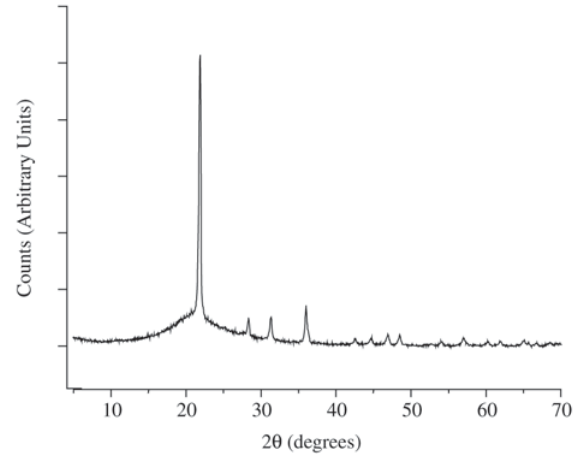
Figure 1 . XRD pattern (arbitrary units) of the powder produced by process 1A. All the peaks are well described by the cristobalite pattern (JCPDS, PDF#39-1425) superimposed on a broad back- ground caused by the remaining amorphous